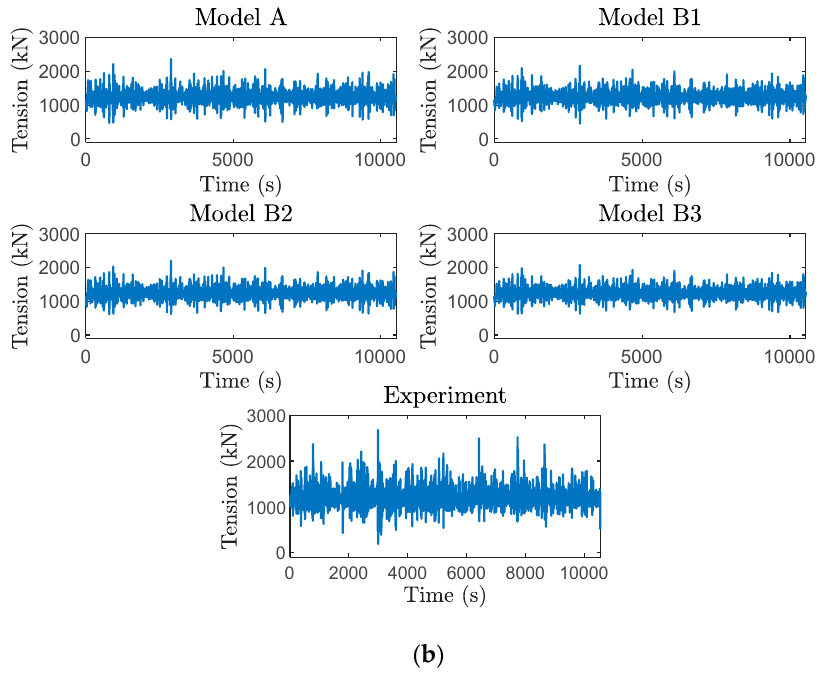
Figure A1. LC3.3 tower base fore-aft shear and up-wave mooring line tension time domain history: ( a ) tower base fore-aft shear time domain history; ( b ) up-wave mooring line tension time domain history.